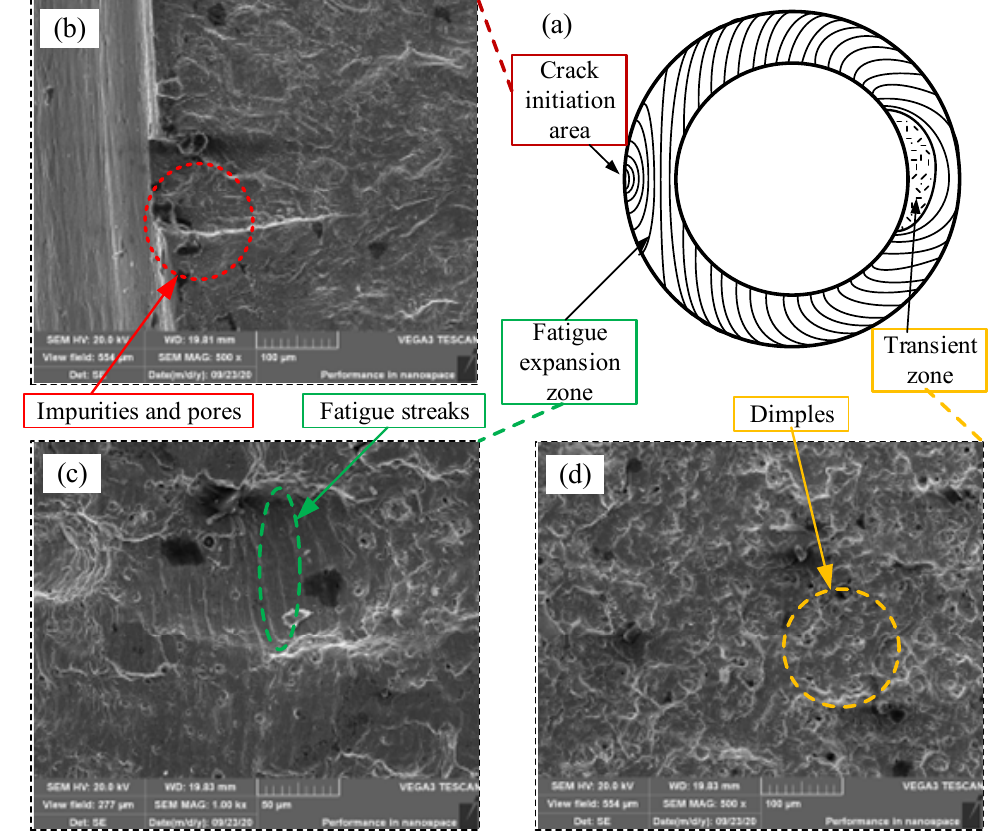
Figure 8. Microstructure of fatigue fracture of thick-walled tube: ( a ) Schematic diagram of the division of fatigue fracture zones; ( b ) 500 times magnification of the crack initiation area; ( c ) 1000 times magnification of the crack propagation area; ( d ) 500 times magnification of the transient region.